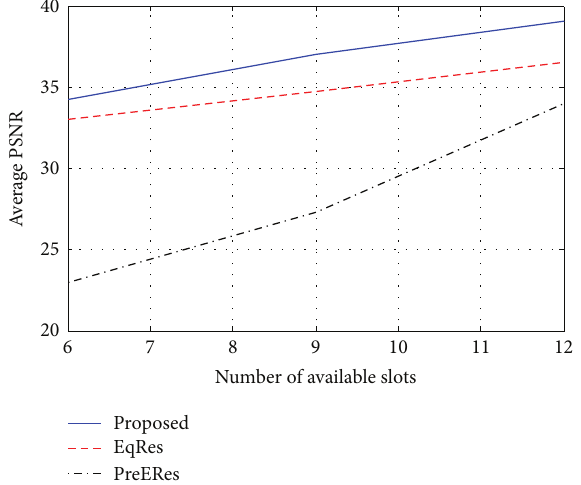
Figure 3: Comparison of the performance of different frameworks in terms of the number of available slots.